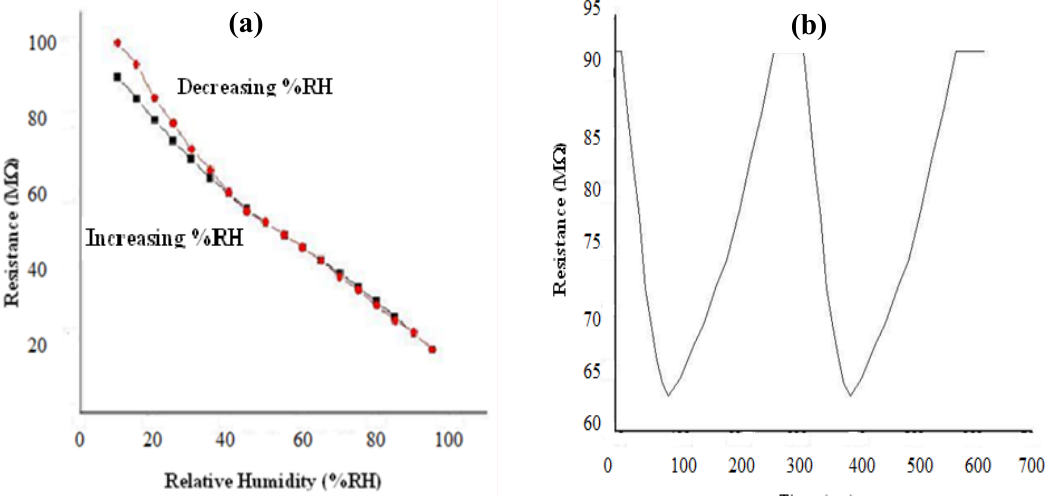
Fig. 6. (a) Hysteresis curve, (b) Response curve at a constant